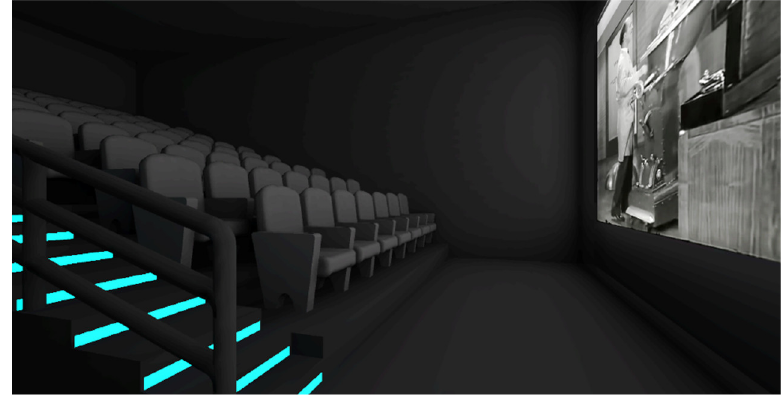
Figure 2. Example of the movie theater.